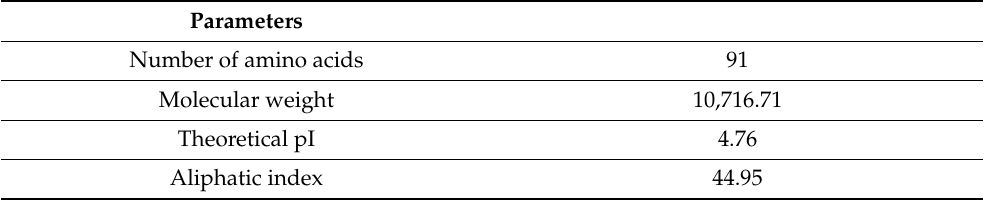
Table 4. Physicochemical properties of AChE1 analyzed using the Protparam webserver.